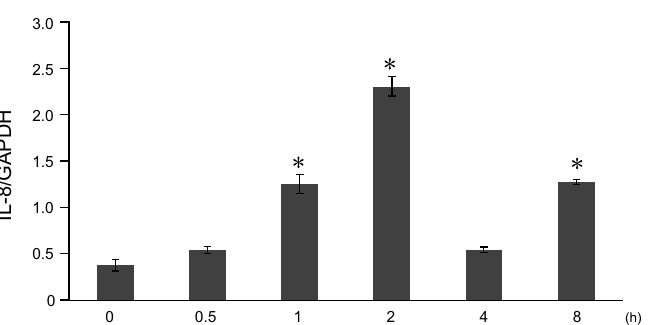
Figure 2. Time course analysis of lipopolysaccharide (LPS)-mediated interleukin-8 (IL-8) gene expression in A549 cells in vitro . A549 cells were cultured until subconfluence and stimulated by LPS at 10μg/ml. After 0 ~ 8 hrs, IL-8 mRNA expression was analyzed by quantitative reverse transcription polymerase chain reaction (qRT-PCR). The IL-8 mRNA levels were normalized to glyceraldehyde-3- phosphate dehydrogenase (GAPDH) levels. Data were expressed in mean±SEM. *P<0.05: compared to LPS 0hr stimulated cells (Mann- Whitney U test),